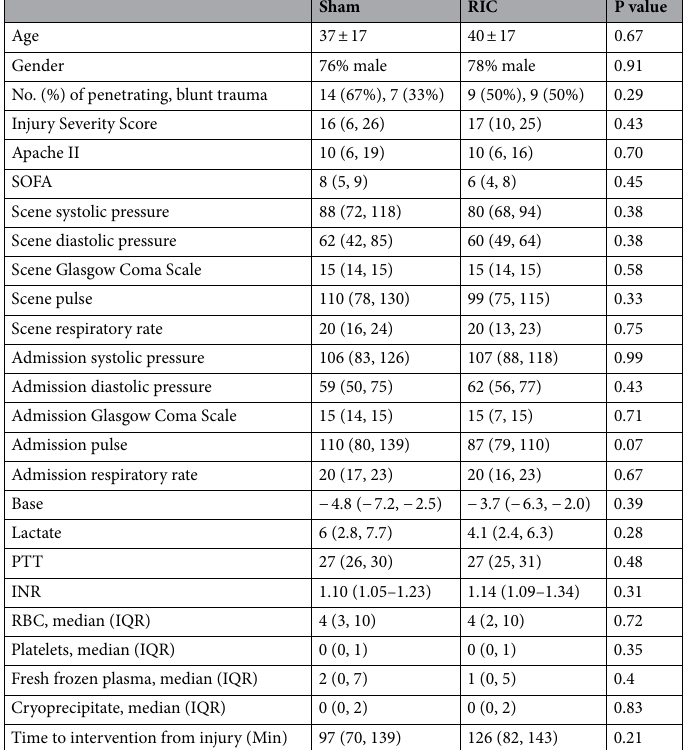
Table 1. Patient prehospital and admission demographics and clinical characteristics. Values represent median (interquartile range) or number (percentile).